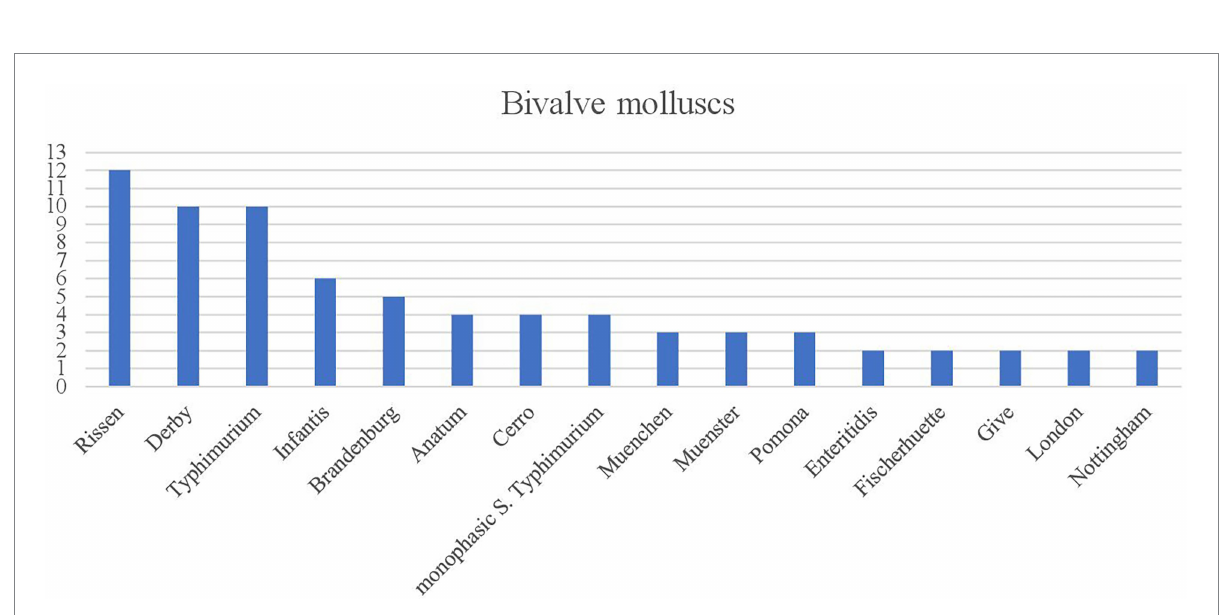
FIGURE 3 Number of Salmonella serovars within the subspecies enterica with an occurrence >1 from 2011 to 2021 isolated from Bivalve mollusks from 2011 to